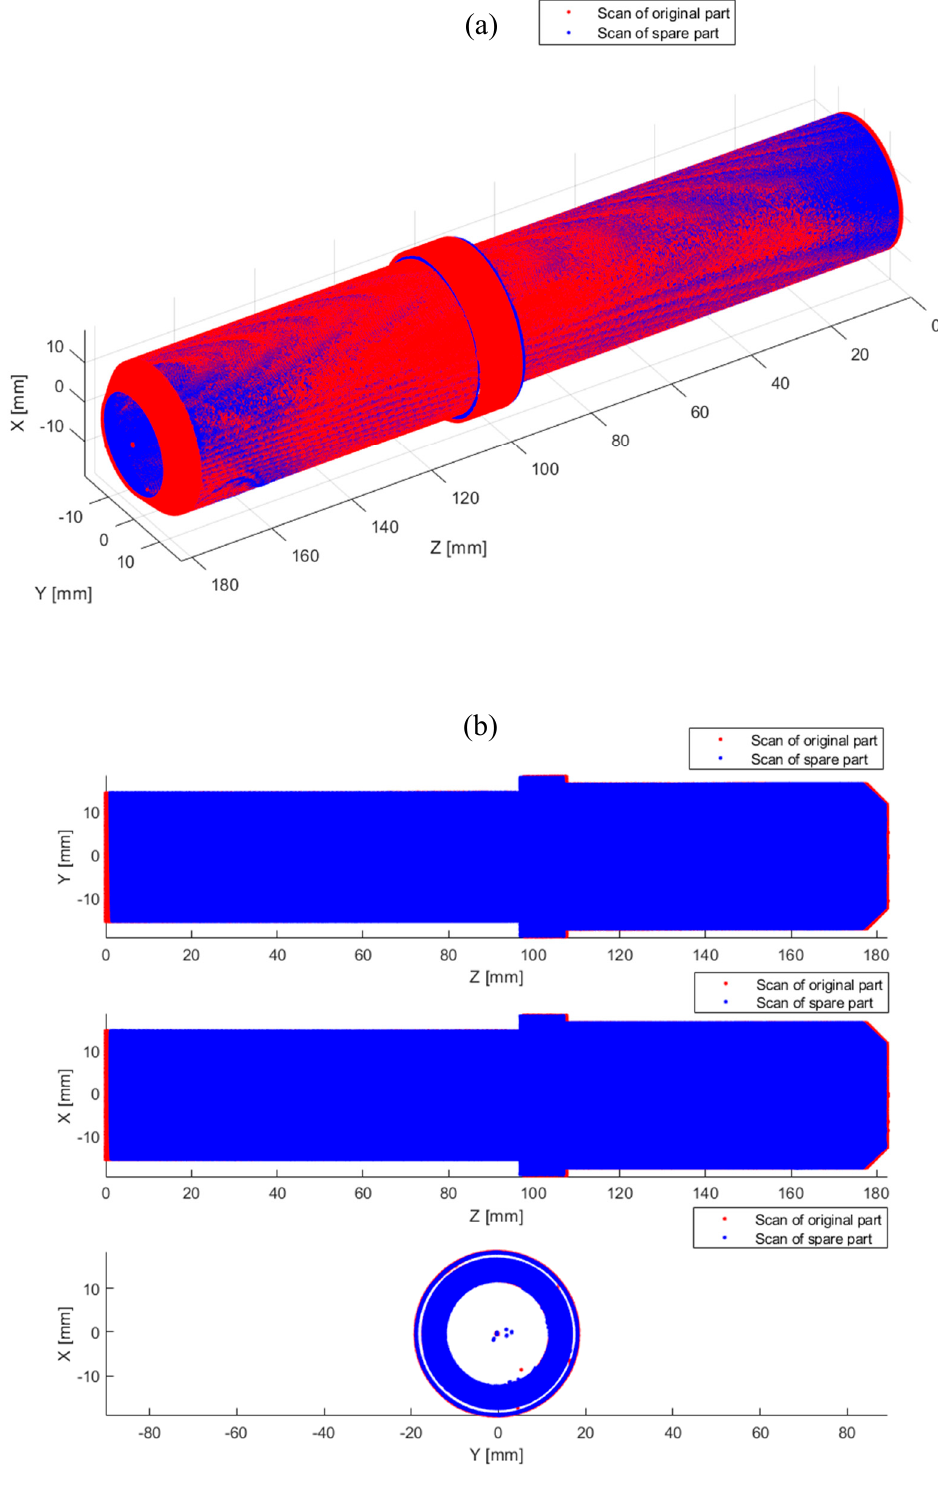
Figure 19. Comparison of 3D scans of the original part and a manufactured spare part, ( a ) 3D view (top), ( b ) side view (bottom).